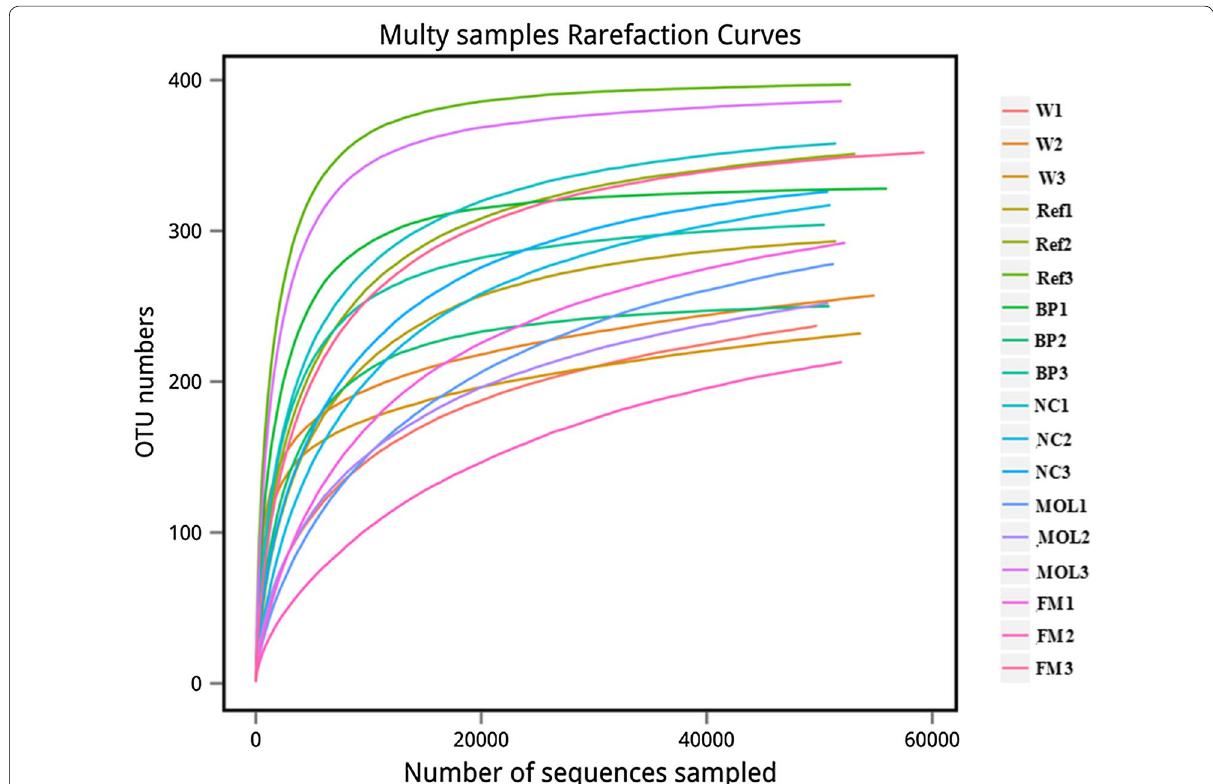
Fig. 1 Rarefaction analyses of all samples. Rarefaction curves represented the number of operational taxonomic unit (OTU) detected in W (W1, W2, W3), Ref (Ref1, Ref2, Ref3), BP (BP1, BP2, BP3), NC (NC1, NC2, NC3), MOL (MOL1, MOL2, MOL3) and FM (FM1, FM2, FM3). Sequences were clustered at 97% sequence similarity